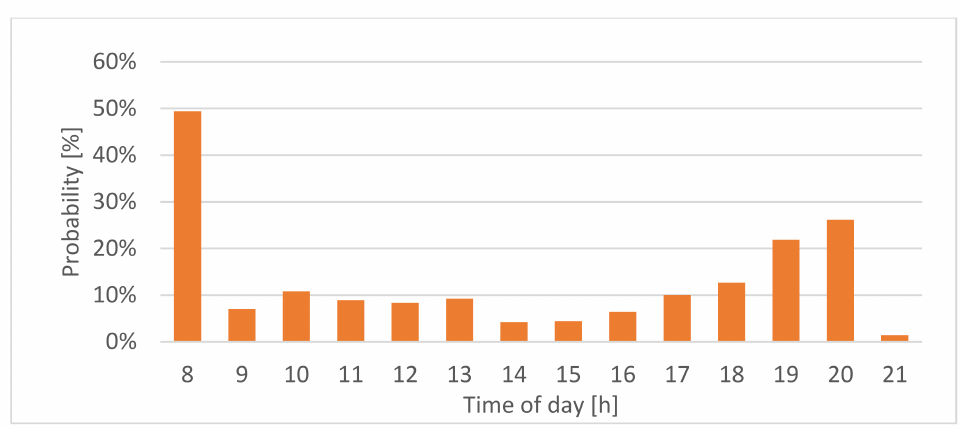
Figure 18. Probability of not meeting the electricity demand. School concept C1 in Addis